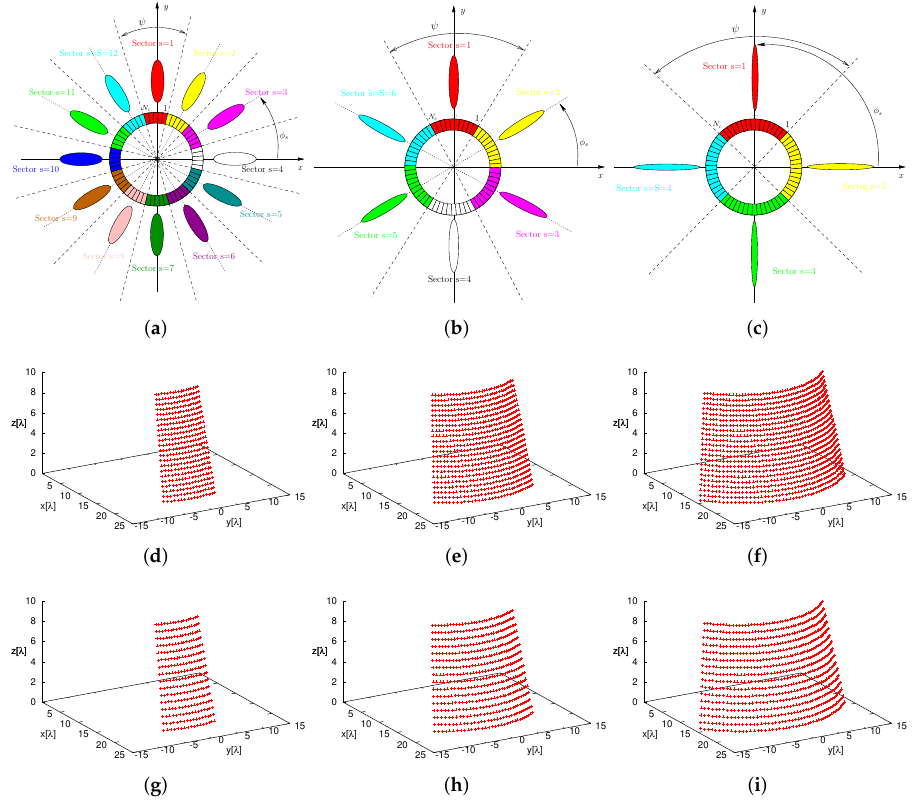
Figure 9. Numerical Assessment ( M = 16, d = λ , B = 7)—CPA configurations when partitioning 2 the lateral surface of the cone in vertical sectors with ( a , d , g ) ψ = 30 ◦ ( → S = 12 and N c = 17), ( b , e , h ) ψ = 60 ◦ ( → S = 6 and N c = 34), and ( c , f , i ) ψ = 90 ◦ ( → S = 4 and N c = 51) widths by using ( d – f ) the FP and ( g – i ) the sparse